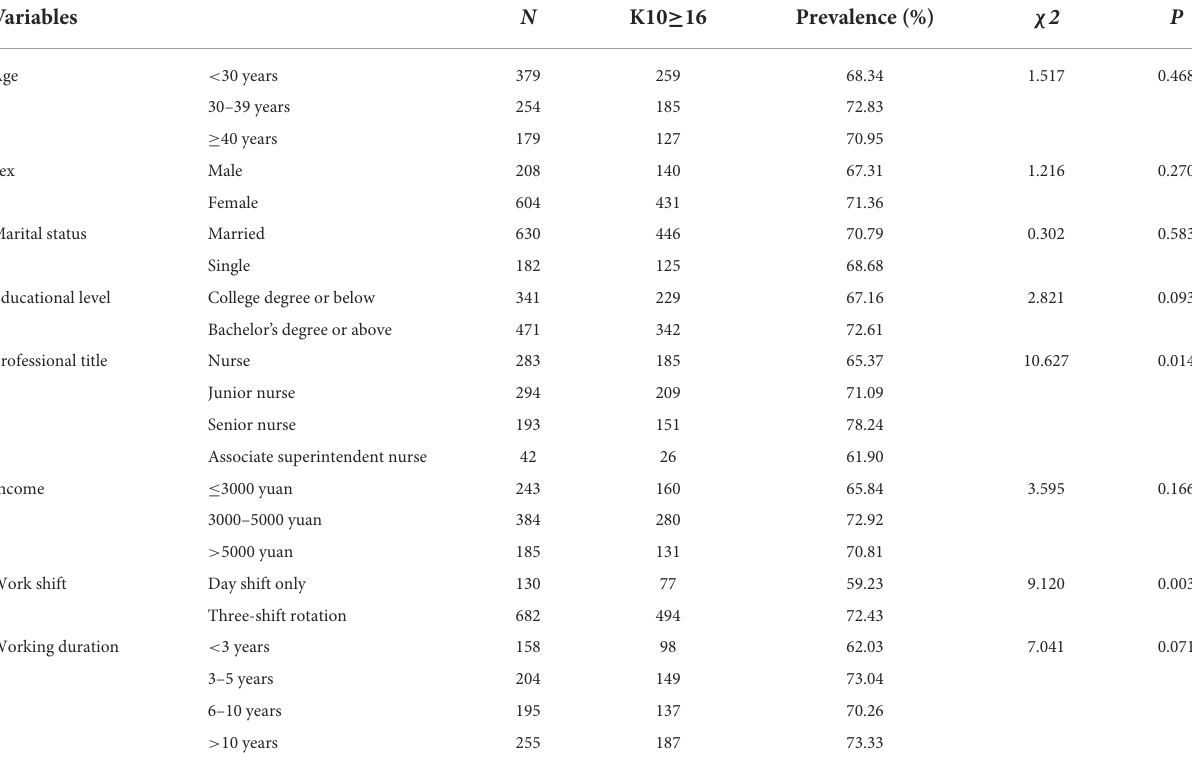
TABLE 1 Sociodemographic characteristics and comparisons of the scores on K10 ( n = 812, Shandong, China).